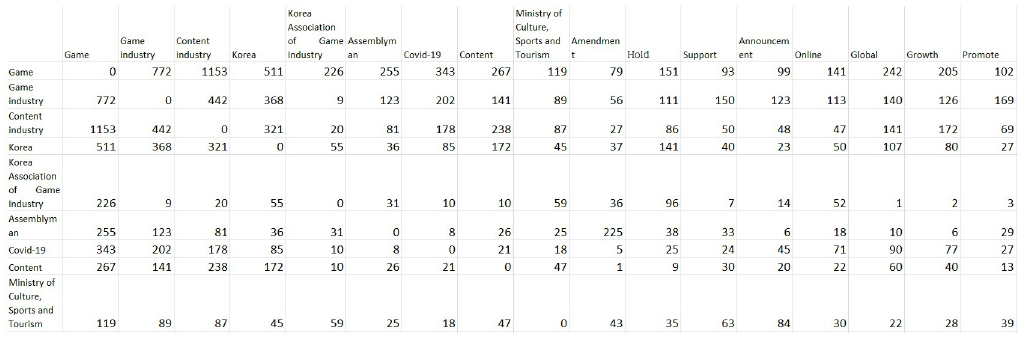
Fig 3. Extracted keywords co-occurrence